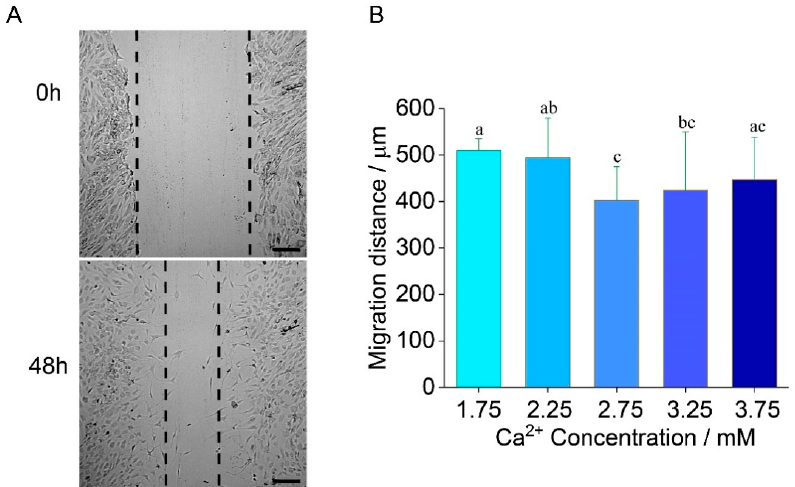
Figure 3. Human chondrocytes migrate at different Ca 2+ concentrations in 48 h. ( A ) A representative scratch assay at 1.75 mM Ca 2+ concentration. Scale bar 250 μ m; ( B ) Cell migration distance decreases by 21% from Ca 2+ concentration 1.75 mM to 2.75 mM. 6 pictures for each group are measured and analyzed. ANOVA and Tukey’s post-hoc is performed for data analysis. Letters (a, b, c) above the bars correspond to distributions that are (letters different) or are not significantly different (letter shared) at the p < 0.05 level.